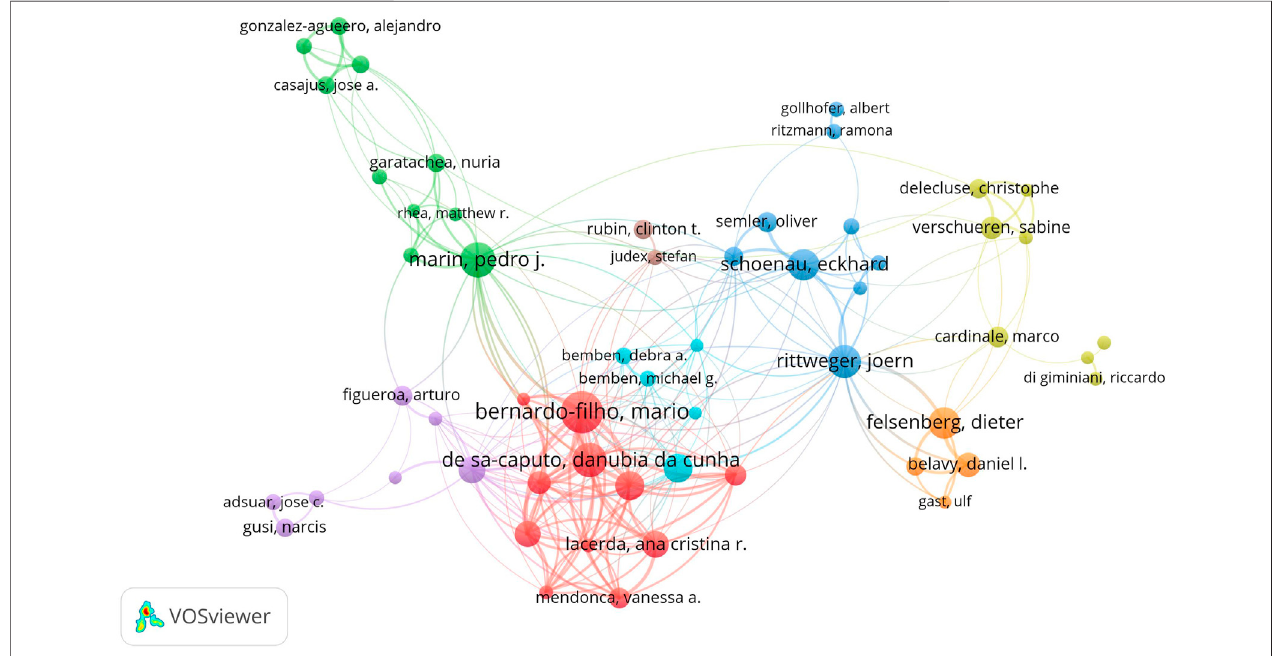
FIGURE 4 | Co-authorship network of productive authors in the research of WBVT.